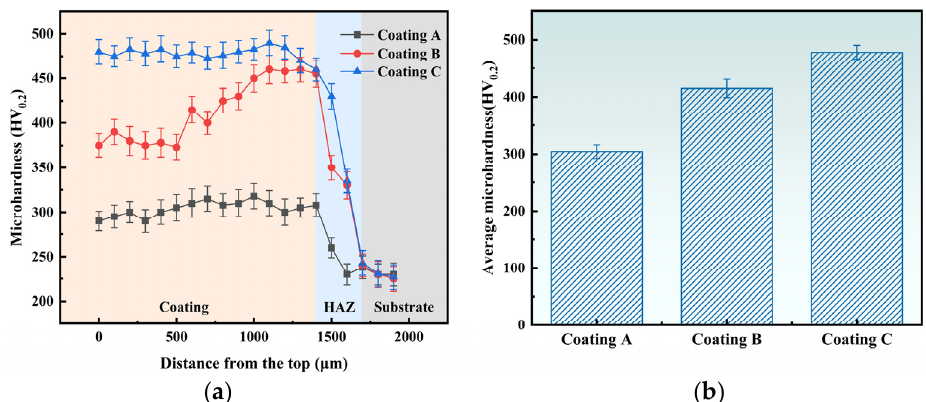
Figure 9. ( a ) Microhardness of different coatings along the depth direction; ( b ) average hardness of cladding layers of different coatings.